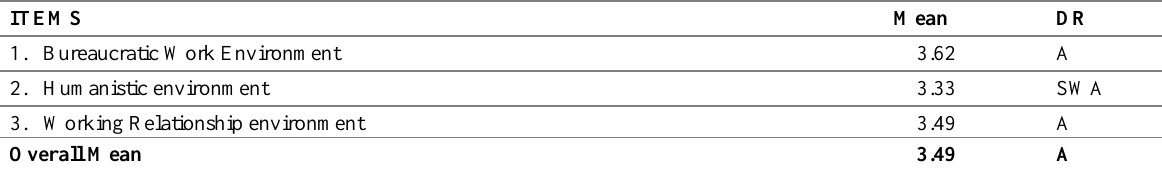
Table 9: Summary of Work Environment